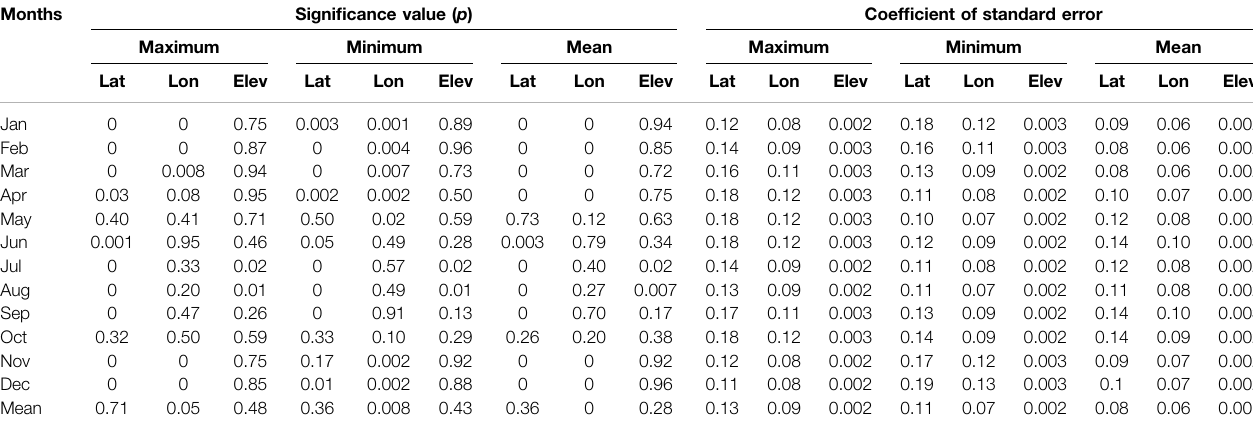
TABLE 3 | The coef fi cient of standard error and the signi fi cance value from the multiple regressions.